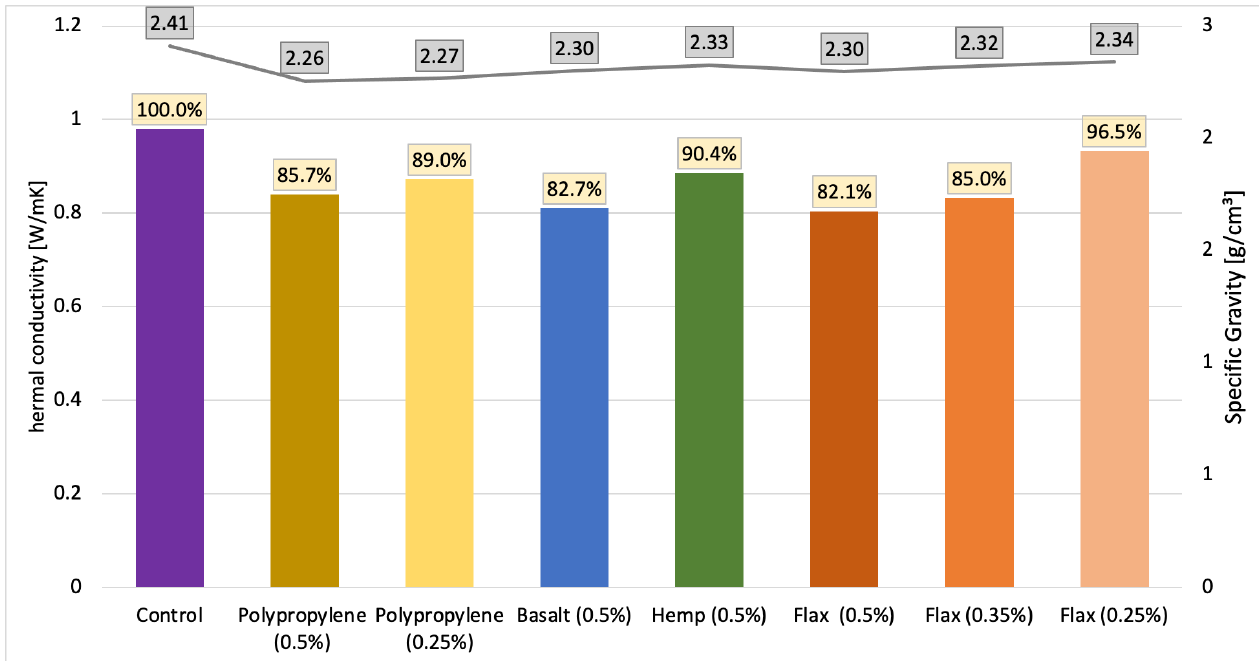
Figure 17. Thermal conductivity [W/mK] and Specific Gravity [g/cm 3 ].